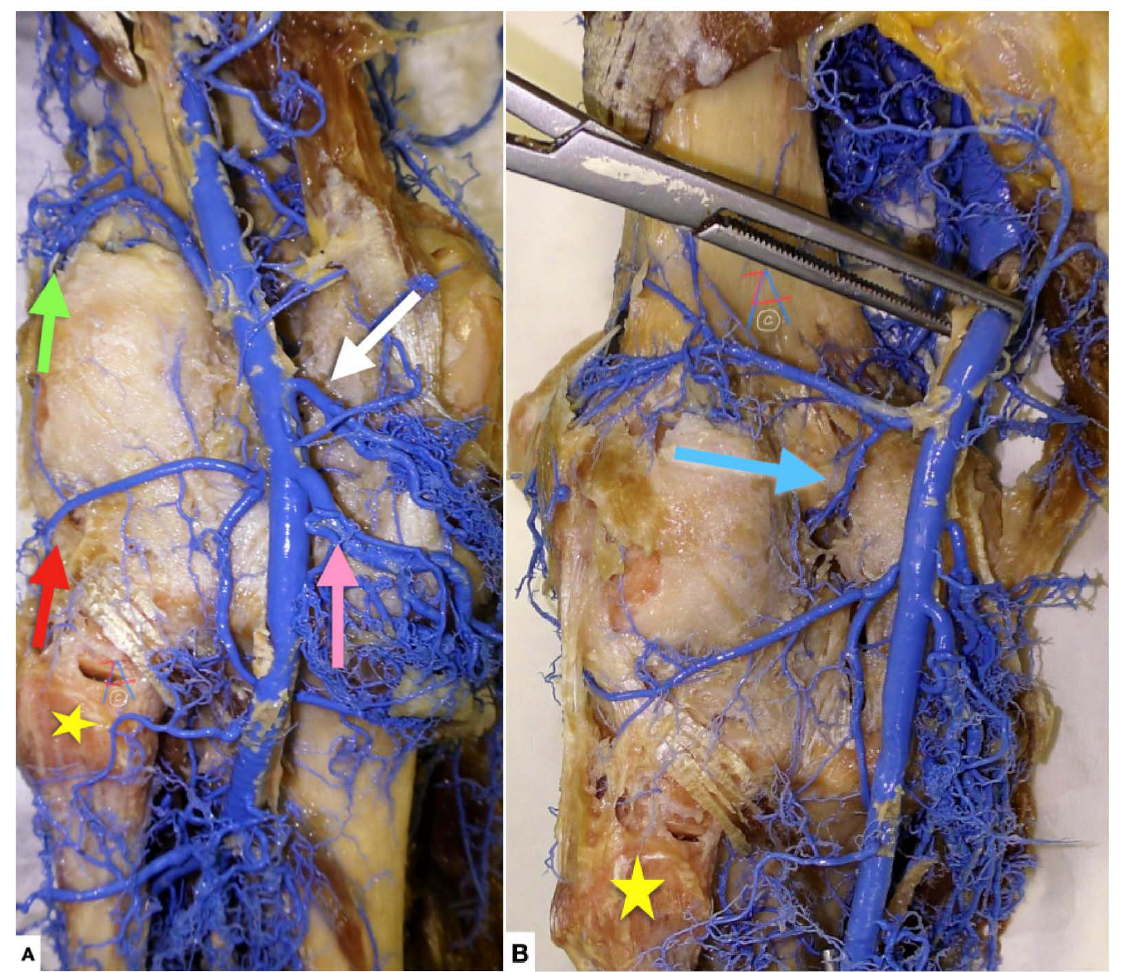
Figure 3. ( A ) Left knee, posterior view. The popliteal artery gives off numerous muscular branches and five genicular branches. They participate in the formation of the periarticular genicular anastomosis, which provides collateral circulation capable of maintaining blood supply to the leg during full knee flexion, which may kink the popliteal artery. Five genicular branches of the popliteal artery supply the capsule and ligaments of the knee joint: The superior lateral genicular artery (green arrow), the superior medial genicular artery (white arrow), the middle genicular artery, the inferior lateral genicular artery (red arrow) and the inferior medial genicular artery (pink arrow). Yellow star: head of fibula. ( B ) Same specimen as in ( A ), where the middle genicular artery (light blue arrow) is